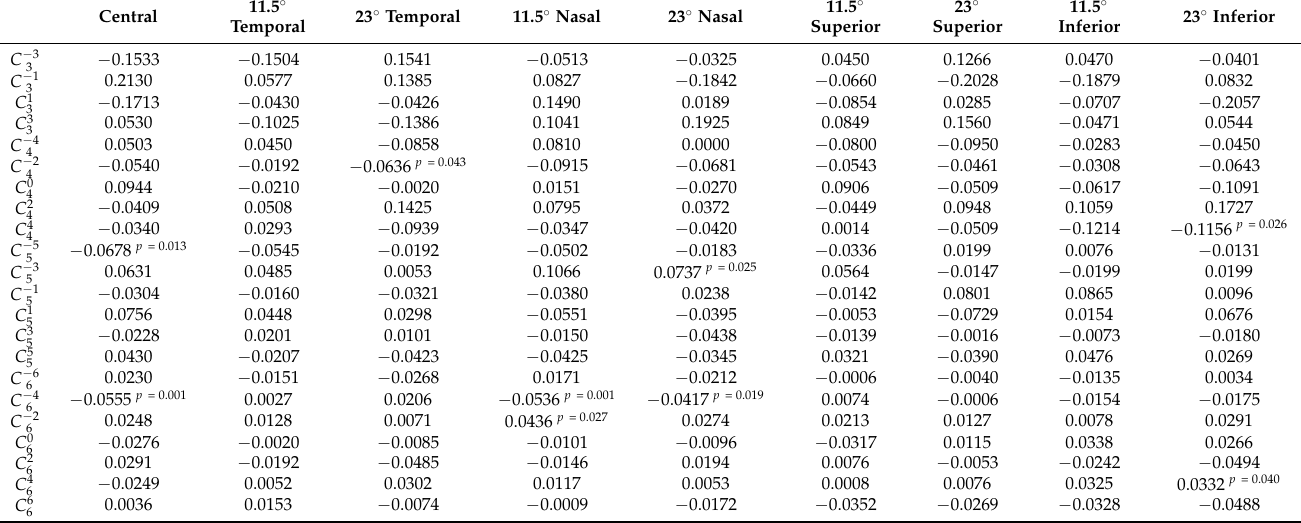
Table 2. Mean difference of the higher order Zernike coefficients ( µ m) between non-accommodated and accommodated status in central and peripheral retina a .